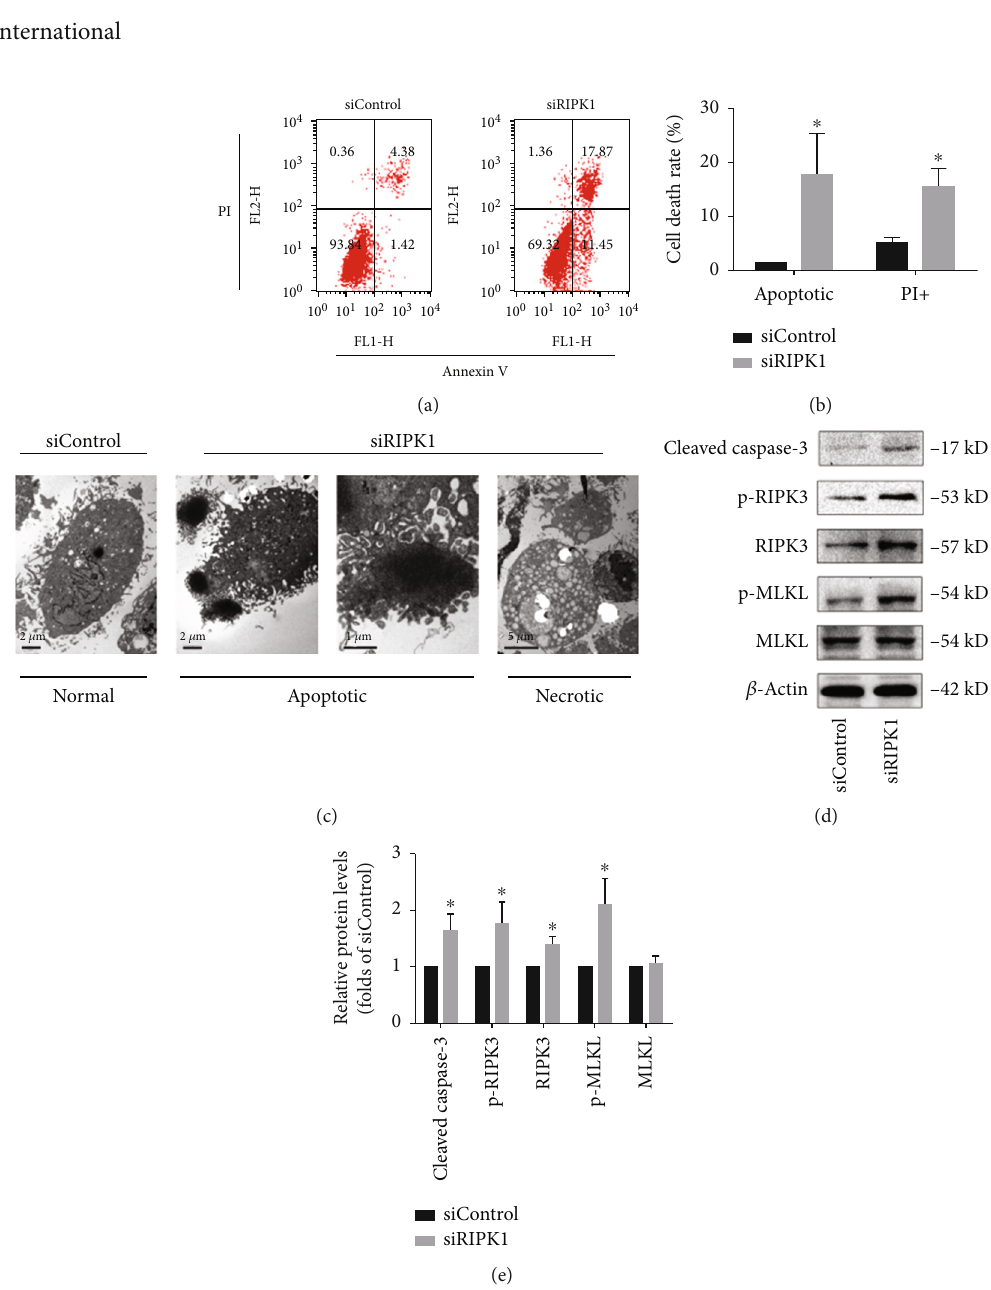
Figure 2: E ff ect of RIPK1 on cell death of bone marrow MSCs. (a) Representative graphs were analyzed using the fl ow cytometer. After 72h transfection with siRNA in bone marrow MSCs, Annexin V/PI staining was used to determine the type of cell death. Annexin V-positive and PI-negative represented apoptotic cells, while PI-positive represented necrotic cells. (b) Histogram analysis illustrated the increase